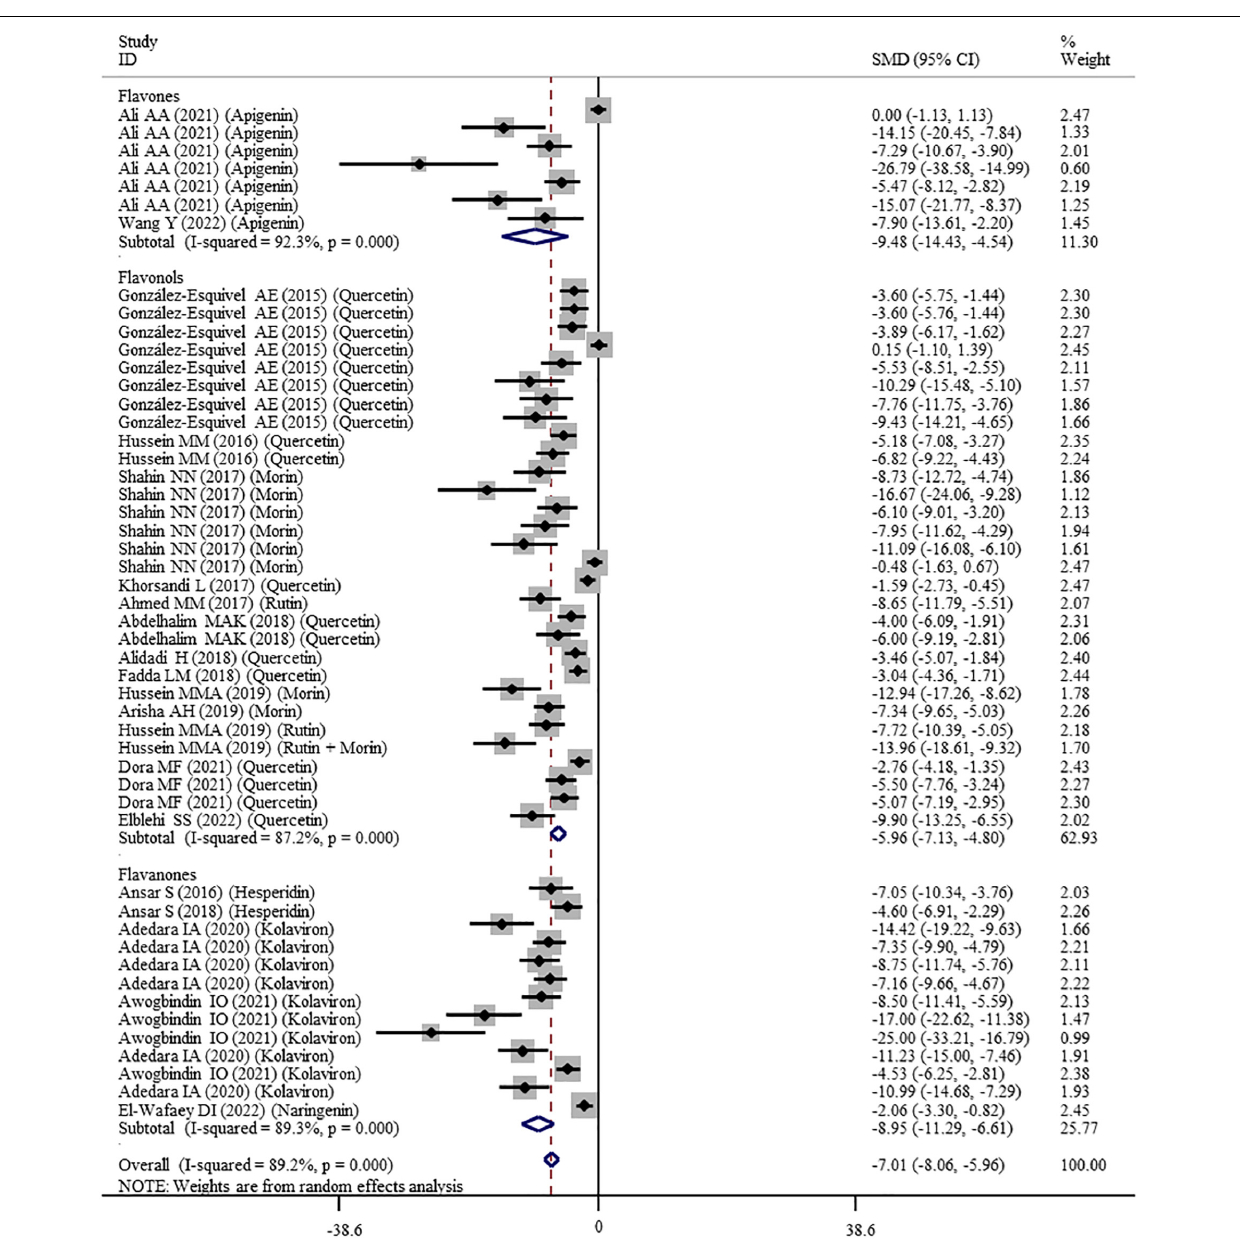
FIGURE 2 | Forest plots to show the effects of flavonoid supplementation on MDA levels compared with the nanomaterial exposure group. MDA, malonaldehyde; SMD, standardized mean difference; CI, confidence